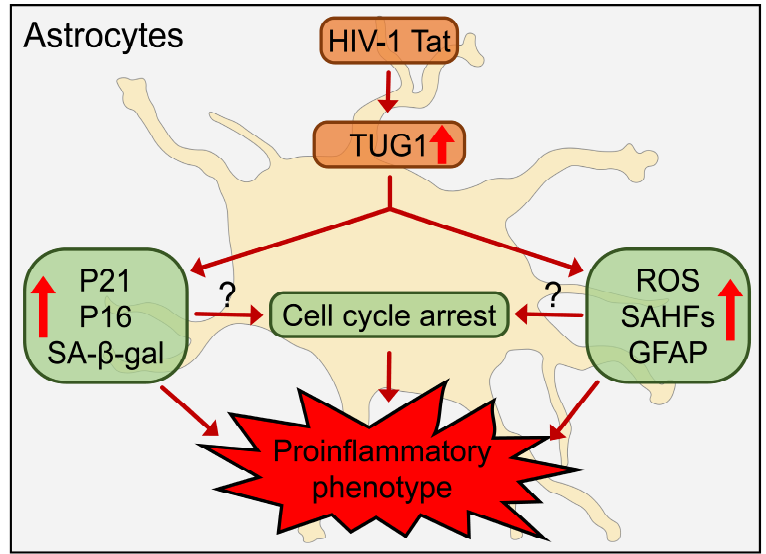
Figure 5. Schematic diagram depicting lncRNA TUG1-mediated astrocyte senescence in the context of HIV-1 Tat.